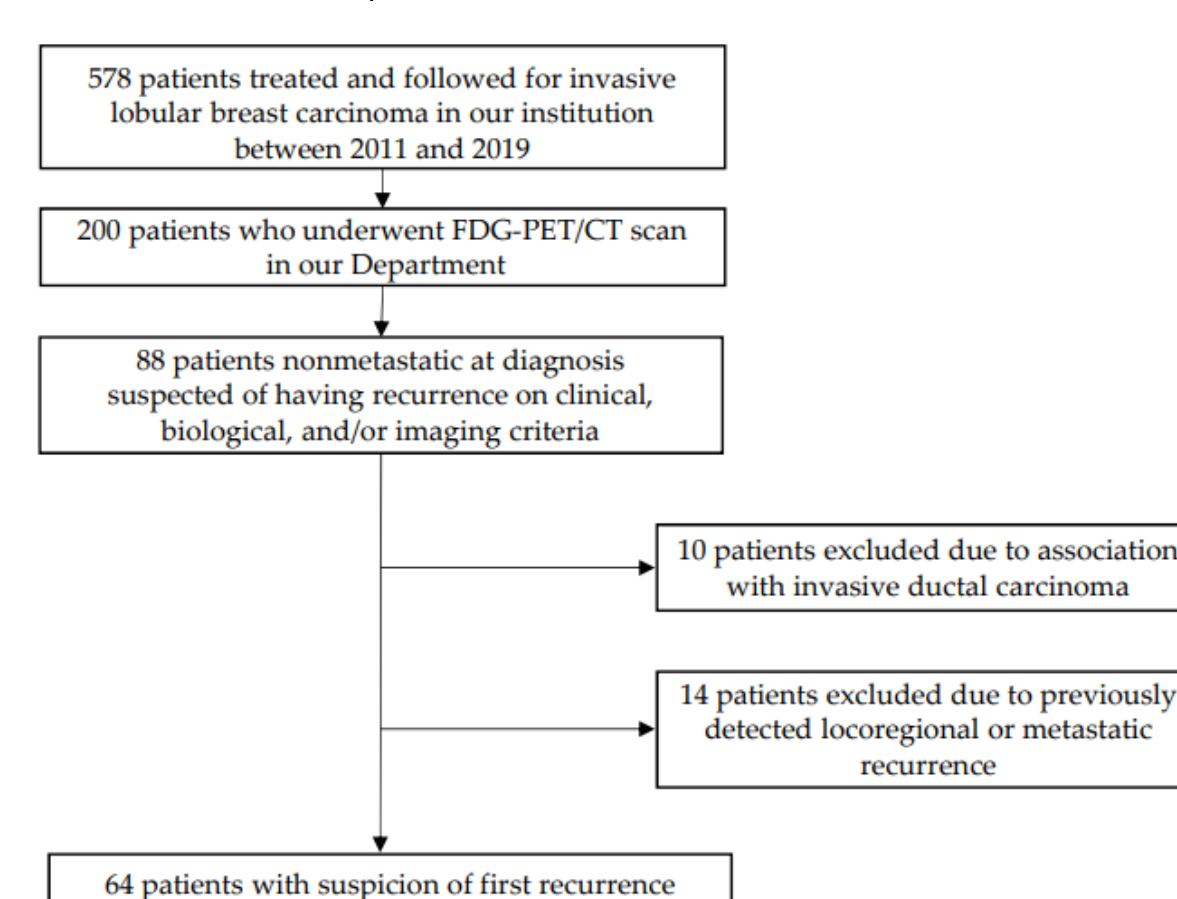
Table 1. Characteristics of the study population. Initial treatment Surgery: 61 (95.3%)